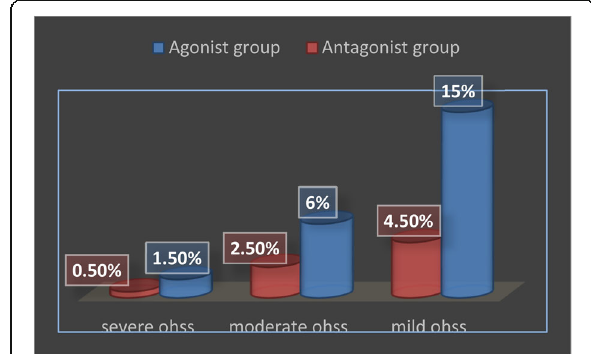
Fig. 4 Bar chart representing the percentages of different forms of OHSS in both